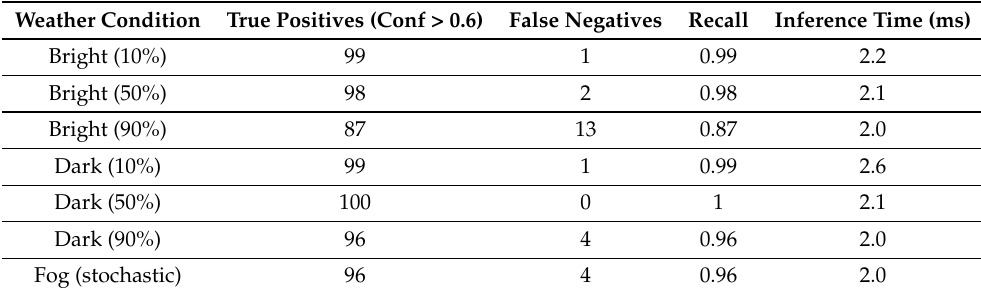
Figure 15. Examples of predictions under extreme weather conditions. ( a ) A 90% glary (sunny) scenario example. ( b ) A 90% dark (night) scenario example. ( c ) A fog scenario example. Table 5. Performance over 100 images described by challenging weather